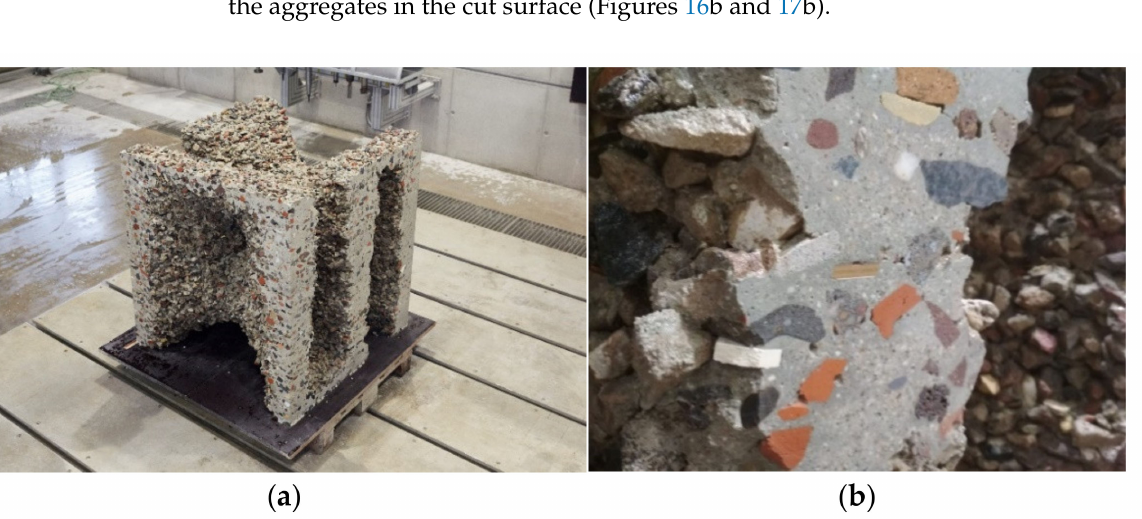
Figure 17. Final demonstrator object: ( a ) overall geometry with milled edges; ( b ) close-up of the milled